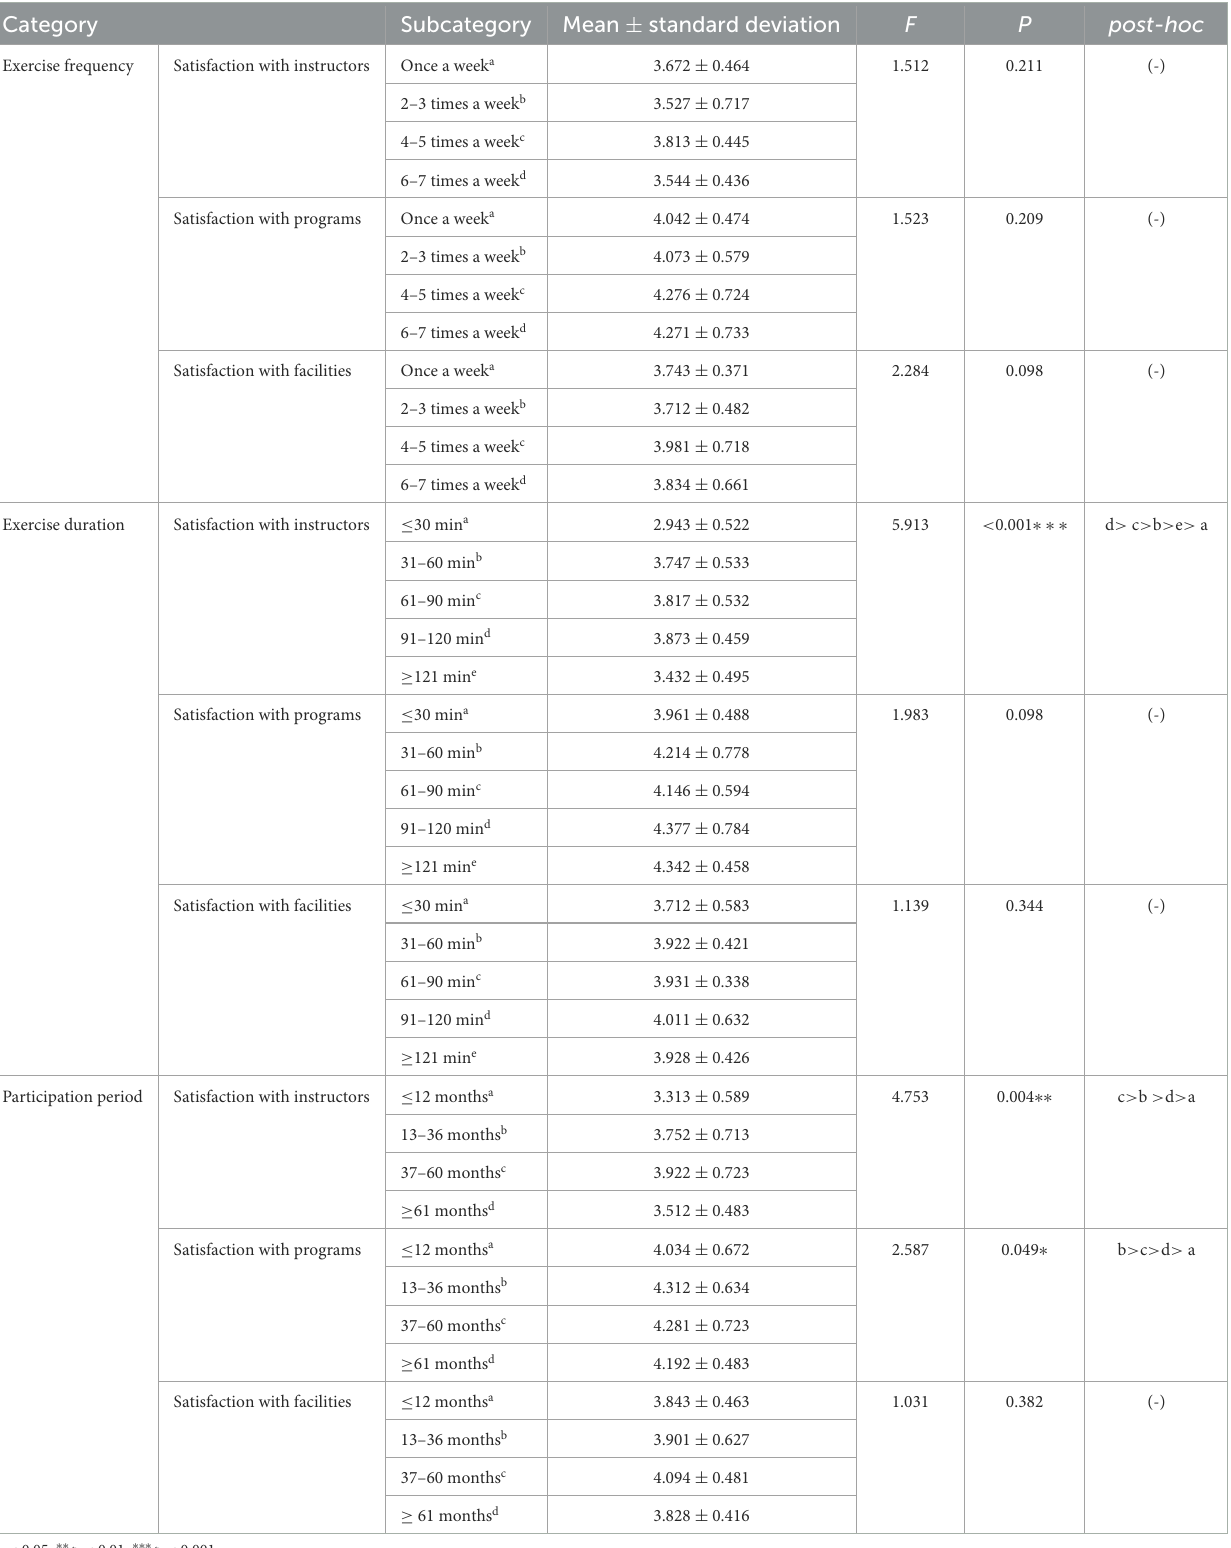
TABLE 5 Results of the one-way analysis of variance (ANOVA) for user satisfaction with the characteristics of the exercise participation of the elderly.